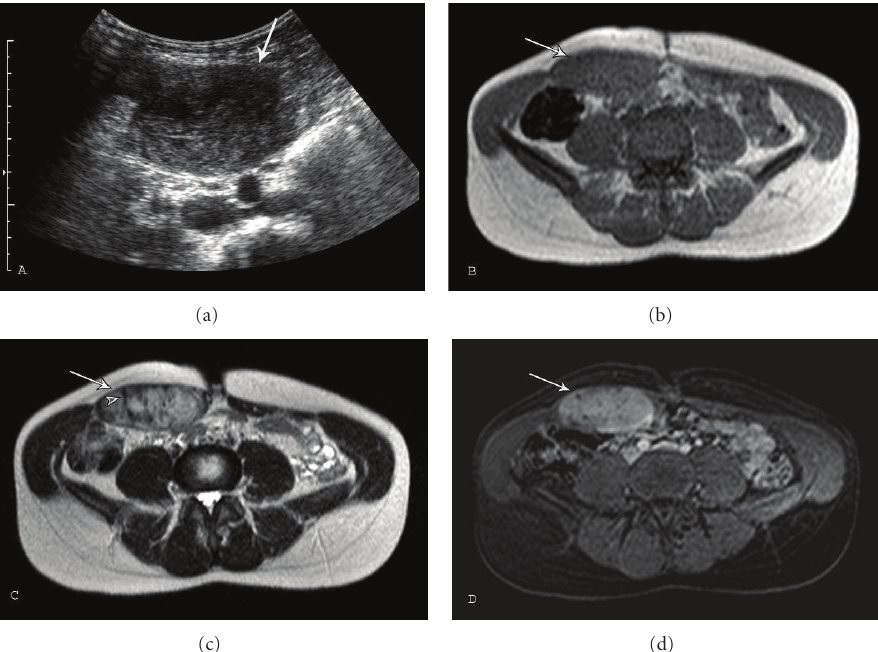
Figure 9: Abdominal fibromatosis of the right rectus abdominis muscle: a 35-year-old female with right rectus abdominis fibromatosis. The lesion continued to grow despite discontinuing oral contraceptive pills and taking ibuprofen. (a) Transverse ultrasound image demonstrates a well-defined, heterogeneous hypoechoic mass. (b) Axial T1- (TR148/TE4.6) and T2-weighted (TR441.2/TE100) sequences reveal a heterogeneous lesion (arrows) with T1 signal similar to skeletal muscle and intermediate to high T2 signal. Low-signal bands (arrowhead) are best evaluated on the (c) T2-weighted image. (d) Axial dynamic thrive (TR4.27/TE2.06) postcontrast fat suppression sequence reveals moderate and di ff use enhancement (arrow) of this lesion with high cellularity and scattered nonenhancing foci corresponding to the collagenized